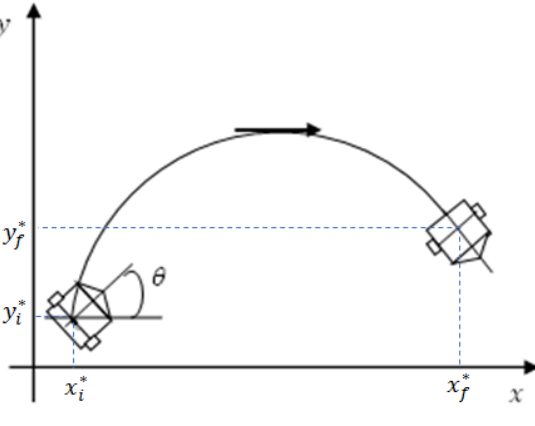
Figure 9. Example of a proposed trajectory.